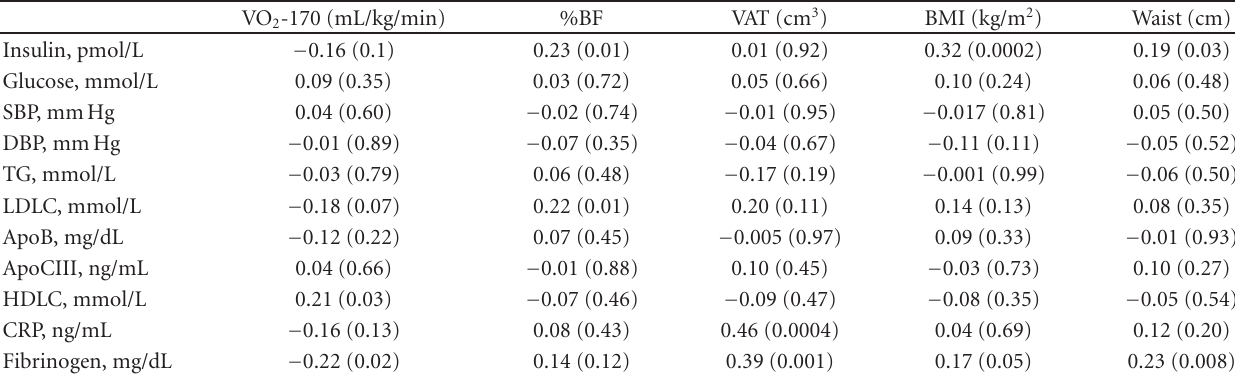
Table 4: Pearson correlations ( P values) between changes in fatness and fitness indices and changes in cardiometabolic